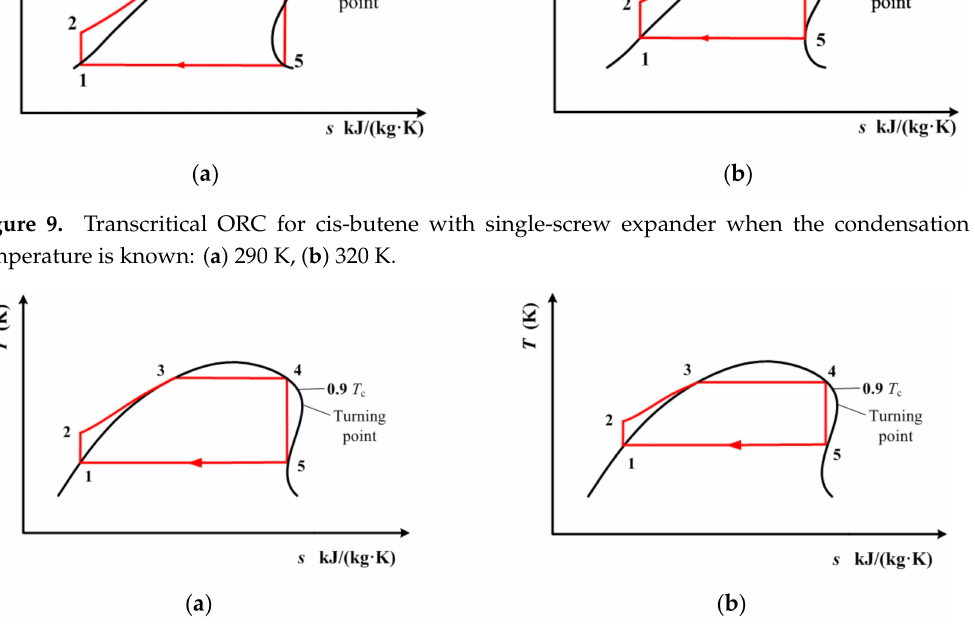
Figure 10. Transcritical ORC for R1234yf and R1234ze(E) with single-screw expander when the condensation temperature is known: ( a ) 290 K, ( b ) 320